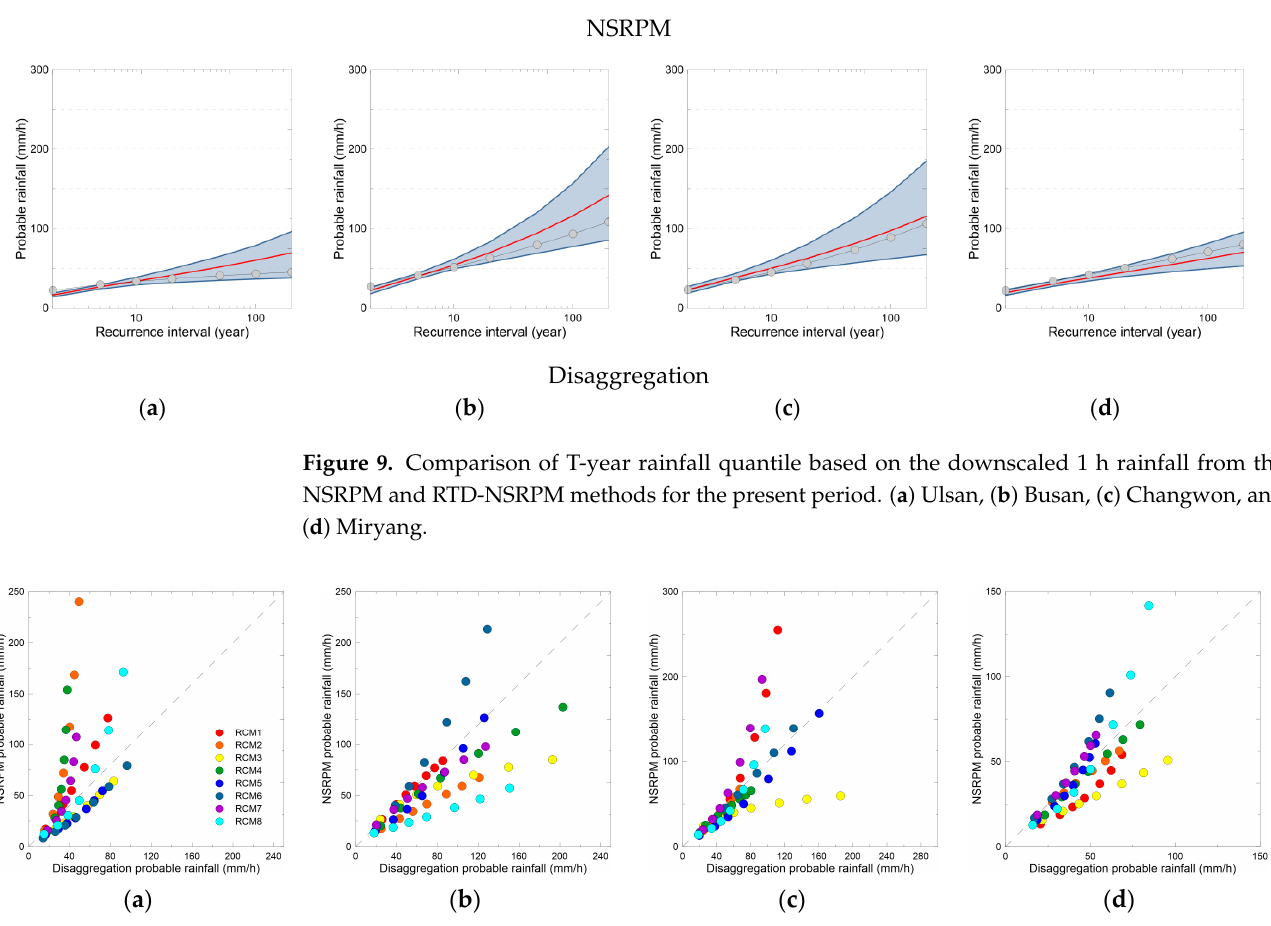
Figure 10. Scatter plots of the rainfall quantile based on the downscaled 1 h rainfalls from the NSRPM and disaggregation methods for the present period. ( a ) Ulsan, ( b ) Busan, ( c ) Changwon, ( d ) Miryang.